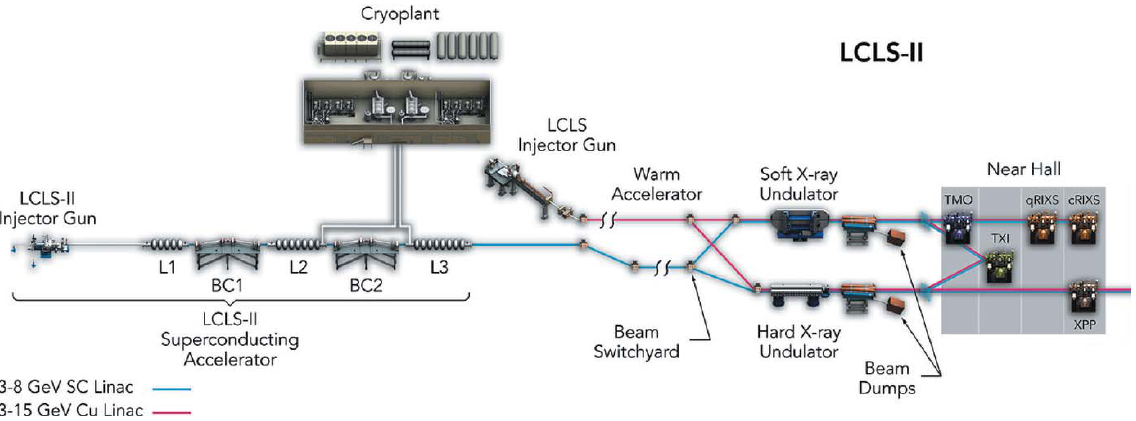
Figure 1 Schematic overview of the new LCLS and NEH layout with both accelerators [LCLS (red) and LCLS-II (blue)]. The LCLS-II X-ray laser is shown alongside the existing LCLS. LCLS uses the last third of SLAC’s two-mile-long linear accelerator – a hollow copper structure that operates at room temperature and allows the generation of 120 X-ray pulses per second. For LCLS-II, the first third of the copper accelerator has been replaced with a superconducting one, capable of a repetition rate of up to 1 MHz. Future Far Hall layout changes for LCLS-II HE are not included.